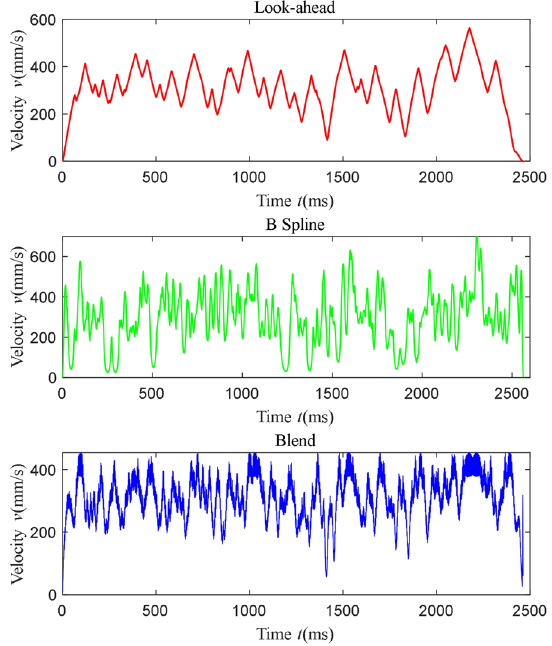
Figure 14 Comparison of jerk values obtained using the three